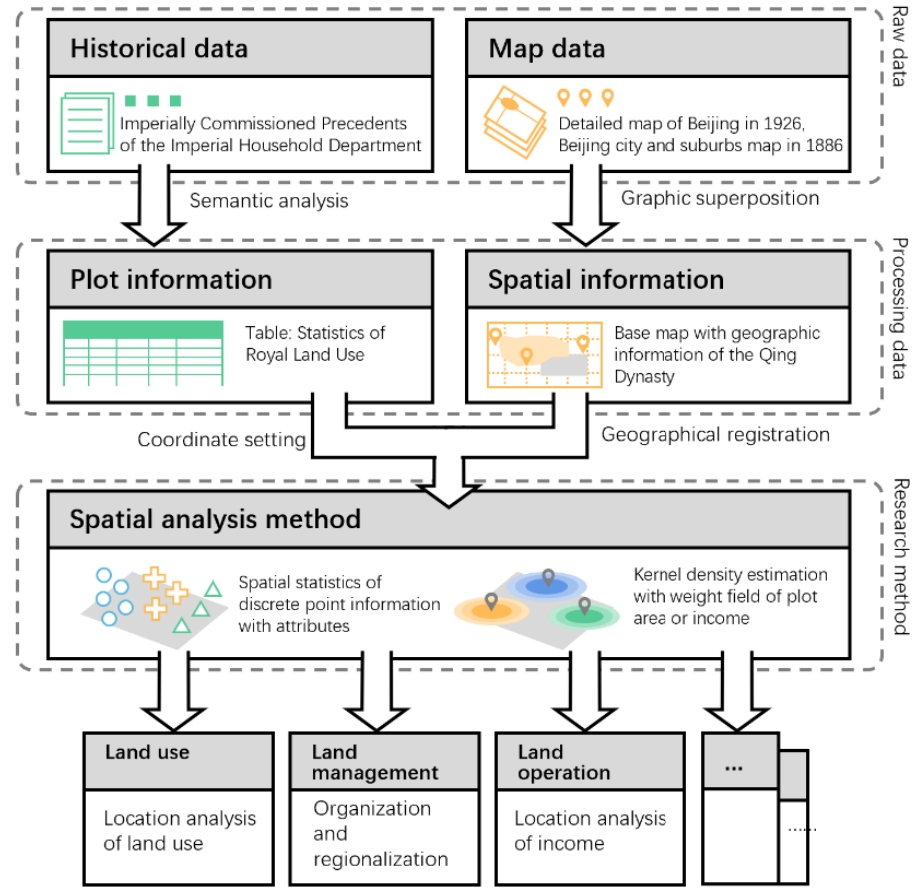
Figure 4. Research method roadmap